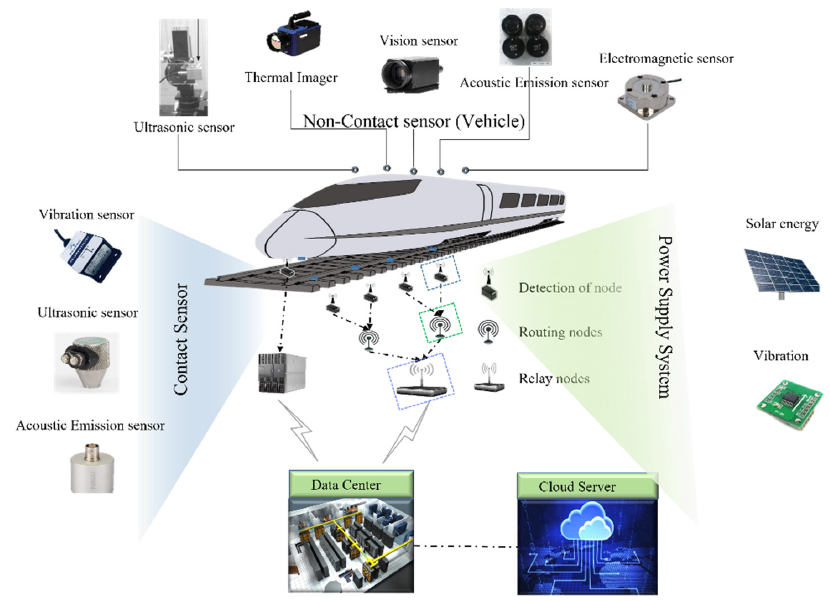
Figure 1. A wireless sensor-based rail defect detection system.